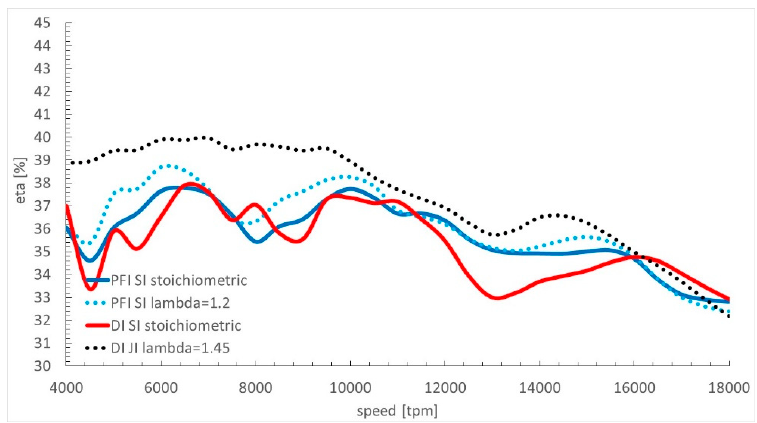
Figure 6. Fuel conversion efficiency of engines stoichiometric and lean.